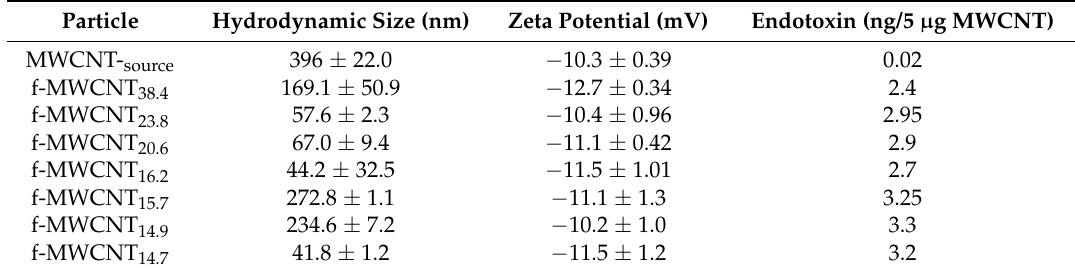
Table 1. Agglomerate size (mean ± SD), zeta potential (mean ± SD), and endotoxin contamination of MWCNT in RPMI culture media after dispersion medium preparation.